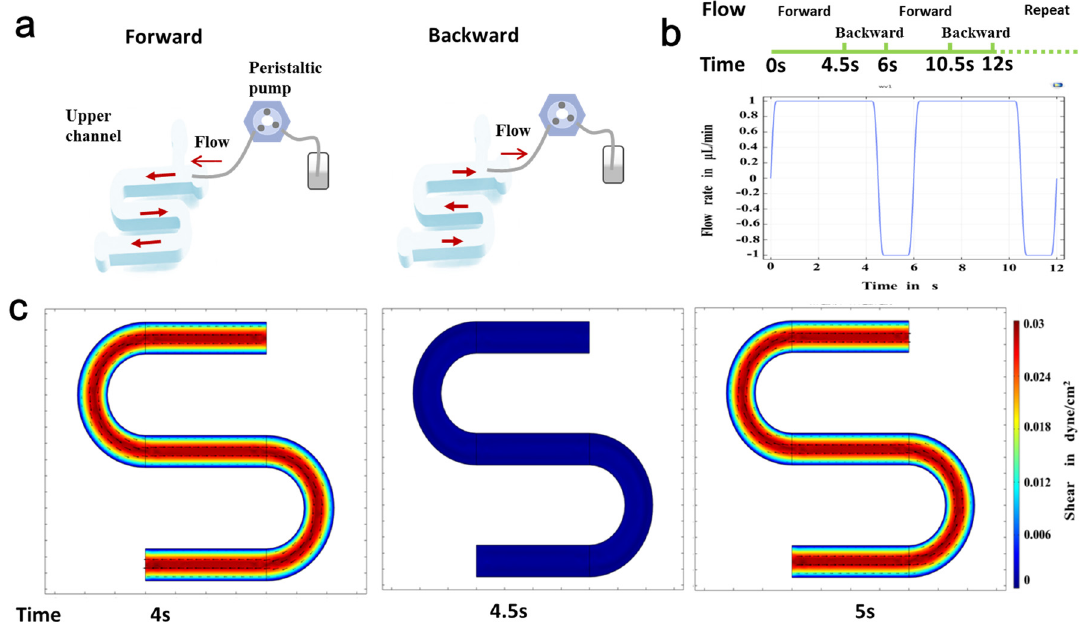
Figure 2. Mathematical simulation of the peristaltic flow in intestine on chip. ( a ) Schematic drawing of peristaltic flow in the upper channel of the chip device. ( b ) The changes of flow velocity as the periodical changes of flow direction. ( c ) The numerical simulation of shear stress in the upper channel by computational fluid dynamics analysis.